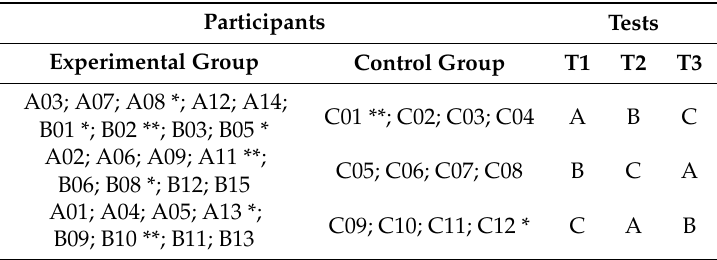
Table 1. Counterbalancing